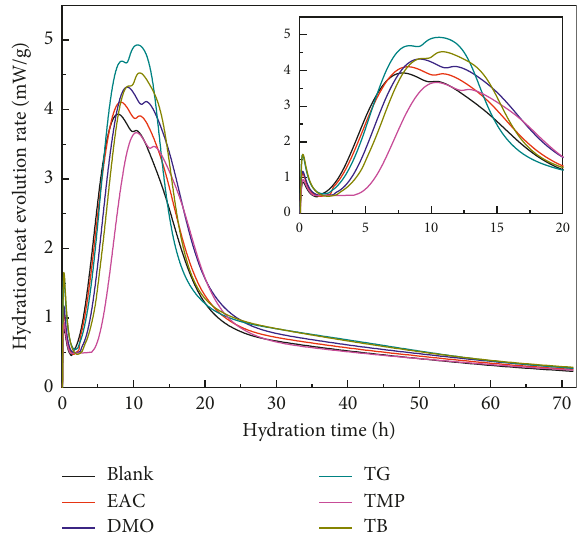
Figure 1: Effect of ester on the rate of heat release of cement hydration.